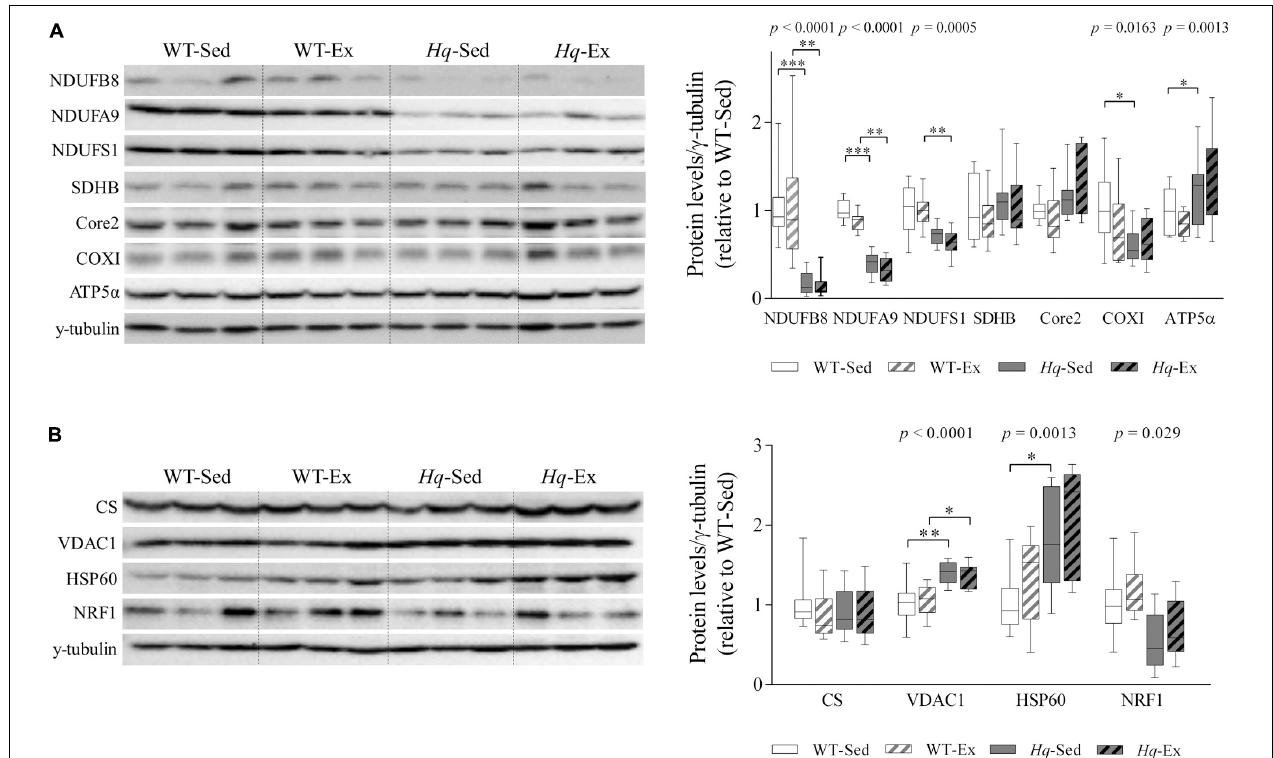
FIGURE 1 | OXPHOS subunits and mitochondrial content. (A) Western blot analysis of representative OXPHOS components and (B) mitochondrial content markers in cerebellum homogenates of wild-type sedentary (WT-Sed, n = 12) and exercise-trained (WT-Ex, n = 11) mice, and of Hq sedentary ( Hq -Sed, n = 11) and exercise-trained ( Hq -Ex, n = 10) mice. Densitometry analysis: protein levels were normalized to γ -tubulin levels; data (median, interquartile range, and min and max values) are expressed relative to levels in the WT-Sed group. Significant p- values for group effect (Kruskal-Wallis test) are shown above the corresponding boxes. Symbols for significant differences in post hoc pairwise comparisons: ∗ p < 0.05; ∗∗ p < 0.01; ∗∗∗ p < 0.001 for Hq -Sed vs. WT-Sed, and Hq -Ex vs .WT-Ex. ATP5 α , ATP synthase subunit alpha; Core 2, ubiquinol-cytochrome C reductase core protein 2; COXI, cytochrome c oxidase subunit I; CS, citrate synthase; HSP60, heat shock protein 60; NDUFA9, NADH:ubiquinone oxidoreductase subunit A9; NDUFB8, NADH:ubiquinone oxidoreductase subunit B8; NDUFS1, NADH:ubiquinone oxidoreductase subunit S1; NRF1, nuclear respiratory factor 1; SDHB, succinate dehydrogenase complex iron sulfur subunit B; VDAC1, voltage-dependent anion-selective channel protein